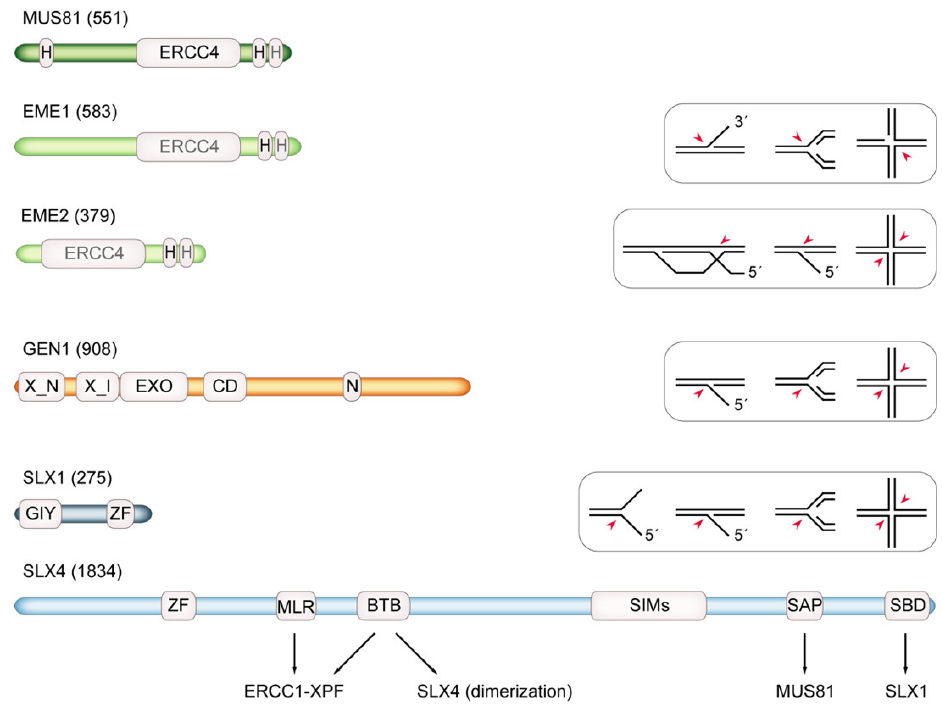
Figure 1 : Human structure-specific endonuclease (SSE) domain structures and DNA substrate specificities. MUS81 and its alternative binding partners EME1 and EME2 (length in amino acids is indicated) contain ERCC4 endonuclease domain and helix-hairpin-helix (H) motifs (gray font